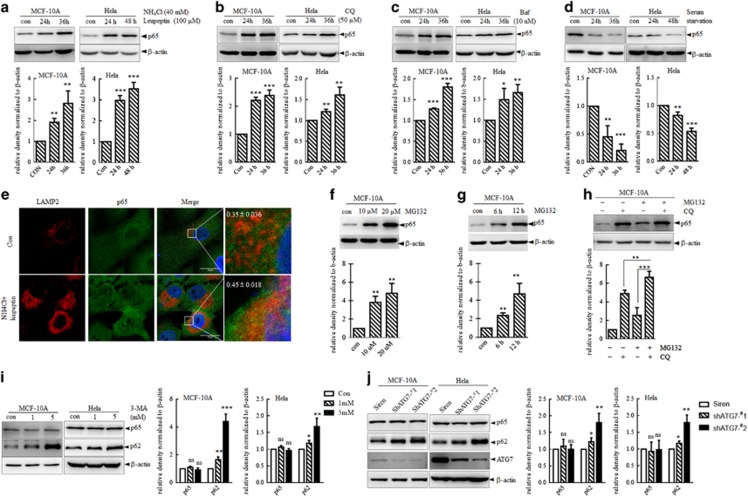
Degradation of p65 through lysosome. (a-d) MCF-10A and HeLa cells were treated with a combination of ammonium chloride (40 mM) and leupeptin (100 μM) (referred to NL hereinafter) (a), CQ (50 μM) (b) and Baf (10 nM) (c), or maintained with or without serum (d) for indicated time. Whole-protein lysates were subjected to immunoblots for indicated protein. Upper, at least three independent experiments were done, and representative image of immunoblot images were shown. Below, blot density was analyzed by ImageJ and quantification analysis was shown. ***P<0.001, **P<0.01 and *P<0.05 as compared with the con group. (e) Immunofluorescence co-staining of LAMP2 and p65 in MCF-10A cells treated with NL for 20 h or not. The colocalization between LAMP2 (red) and p65 (green) was analyzed by JAcoP plugin of ImageJ and values were presented as mean±s.e.m. Scale bar represents 20 μm. (f, g) f: MCF-10A cells were treated with MG132 for 12 h at indicated concentration, g: MCF-10A cells were treated with MG132 (10 μM) for indicated time. Whole-cell lysates were analyzed with immunoblots. Representative images were provided in left and quantification analysis of blot density was provided in right. *P<0.05 as compared with the con group. (h) MCF-10A cells were treated with MG132 (10 μM) or CQ (100 μM) alone or with a combination of MG132 and CQ and lysed for immunoblots for indicated proteins. Representative images were provided in left and blot density quantification analysis was shown in right. **P<0.01 and ***P<0.001 as compared with each group. (i, j) The effect of macroautophagy on the expression on P65. (i) MCF-10A and HeLa cells were treated with 3-MA for 24 h with indicated concentrations followed by immunoblotting for indicated proteins. (j) MCF-10A and HeLa cells were stably infected with Siren empty vector or shRNAs against ATG7 followed by immunoblots analysis of indicated proteins. Representative images were provided in left and quantification analysis of blot density of p65 and p62 were shown in right. ns, no significance. *P<0.05, **P<0.01 and ***P<0.001 as compared with con or siren in each group.